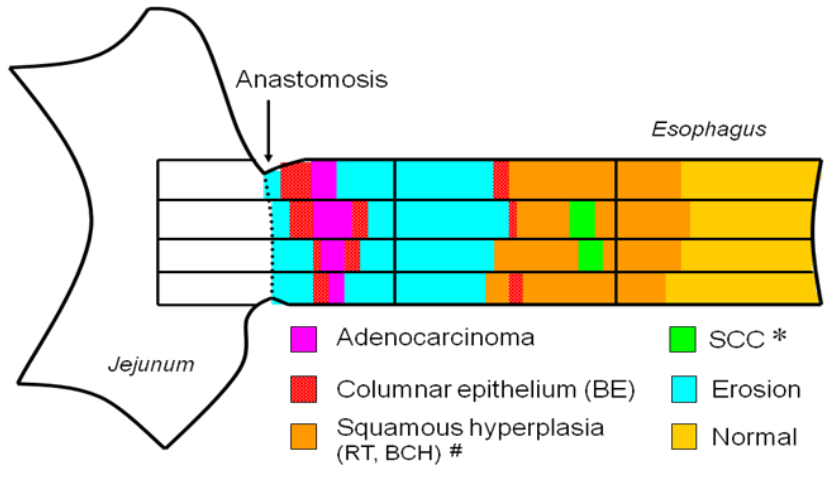
Figure 6. Columnar-lined metaplasia appears near esophagojejunostomy, surrounded by erosion. Adenocarcinoma scatteringly develops in the area showing columnar-lined epithelium. On the other hand, squamous cell carcinoma develops in the area showing squamous hyperplasia, which is located proximal to the columnar-lined